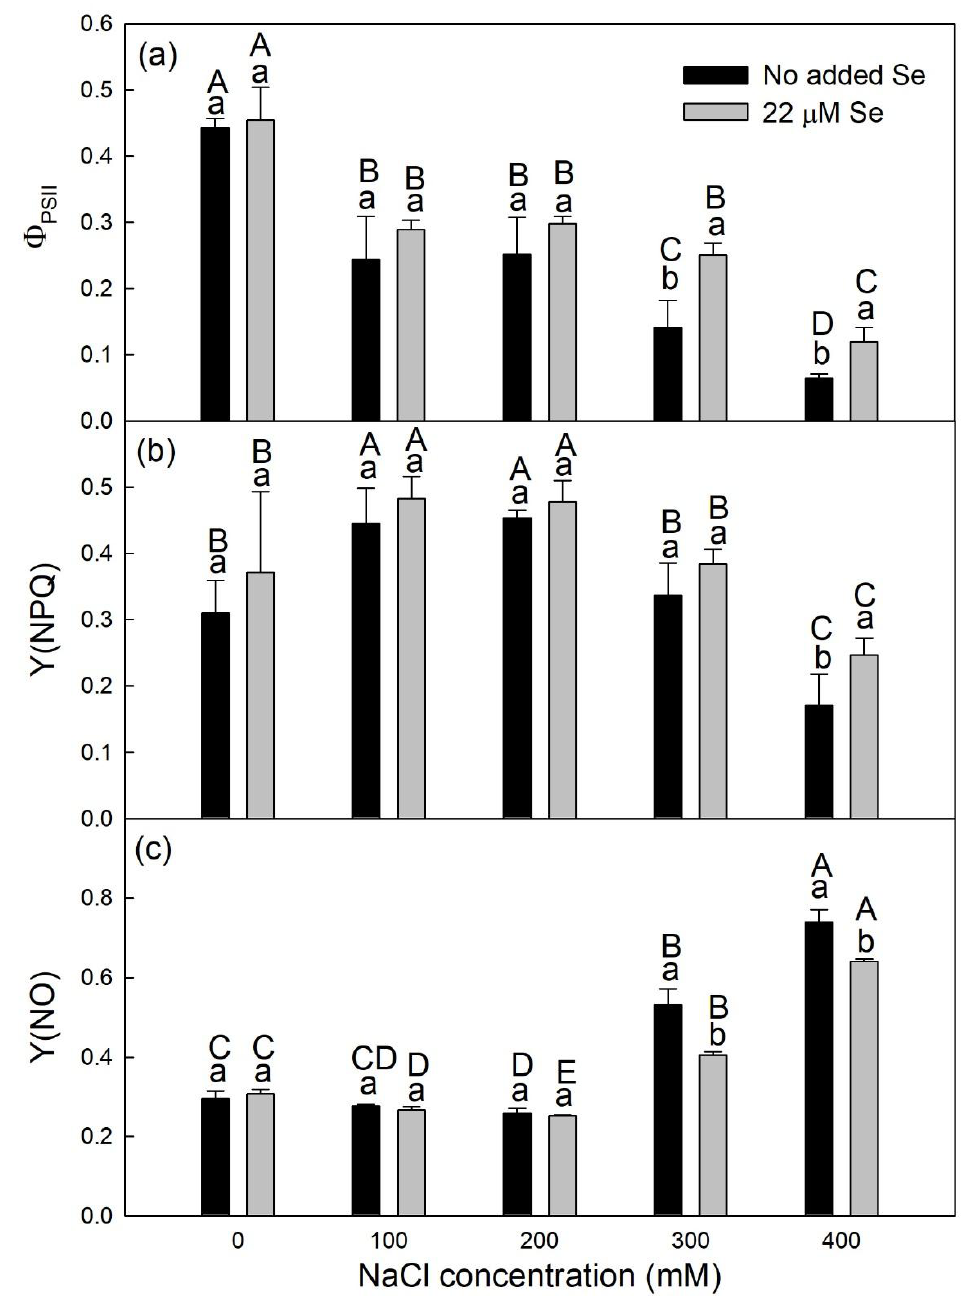
Figure 3. Means ± SD ( n = 4) of the e ff ective quantum yield of photosystem II under illumination ( Φ PSII ) ( a ), quantum yield of regulated energy dissipation of photosystem II (Y(NPQ)) ( b ), and the quantum yield of non-regulated energy dissipation of photosystem II (Y(NO)) ( c ) of leaves collected from untreated seedlings (No added Se) and Se-treated seedlings (22 µ M Se) under di ff erent NaCl concentrations. Values followed by di ff erent letters statistically significantly di ff er at p < 0.05. Means with di ff erent lowercase letters significantly di ff er by a t -test between Se treatments (No added Se and 22 µ M Se) at the same NaCl concentration. Means with di ff erent capital letters significantly di ff er by an LSD test under the di ff erent NaCl concentrations in separate untreated and Se-treated groups ( p <